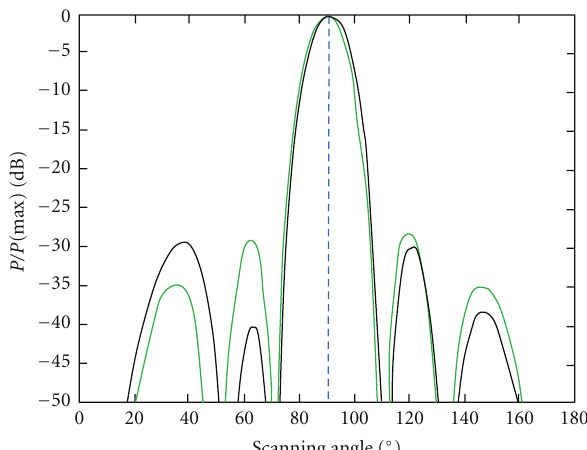
Figure 6: The beam pattern received with 20 neurons in the hidden layer—following ES.